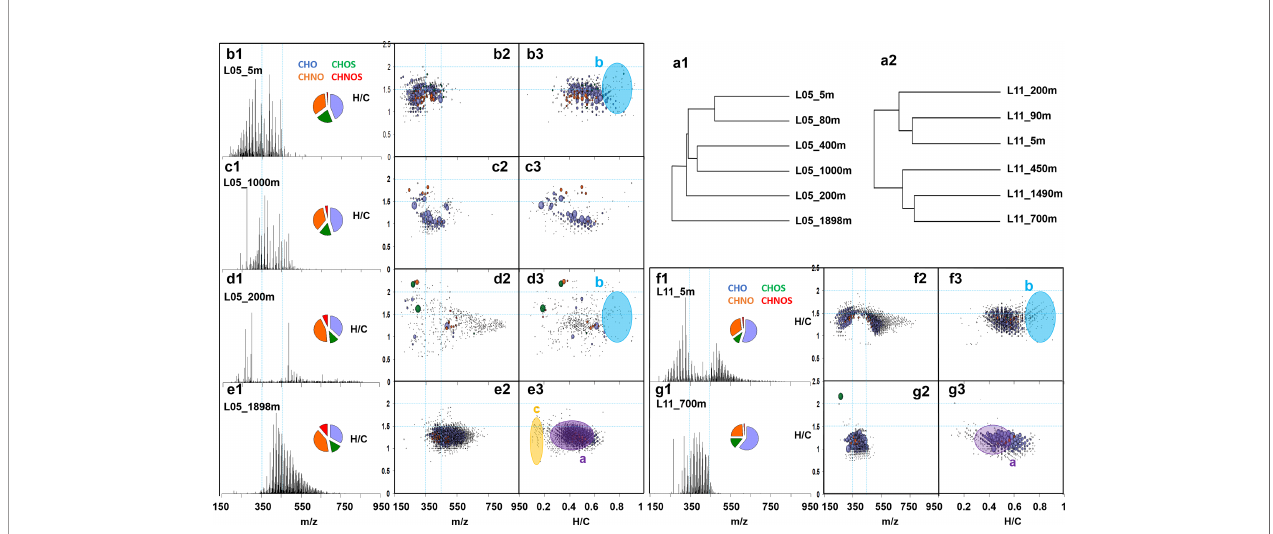
FIGURE 3 | Comparative analysis of intensity weighted negative ESI FTICR mass spectra of marine SPE-DOM in stations L05 and L11 produced hierarchical cluster analysis (HCA) diagrams (a1, a2). From top to bottom rows: FTICR mass spectra from m/z 150-950 with the assigned molecular compositions and relative proportions of color coded CHO (blue), CHOS (green), CHNO (orange) and CHNOS (red) molecular series, shown as van Krevelen diagrams and mass edited H/C ratios of the relatively more abundant compositions found in near surface layers (L5_5m and L5_80m) (b1-b3), mesopelagic layers (L5_400m and L5_1000m) (c1- c3), top mesopelagic layer (L5_200m) (d1-d3), L05 deep (e1-e3), upper layers (L11_5m, L11_90m and L11_200m) (f1-f3), and deep layers (L11_450m, L11_700m and L11_1490m) SPE-DOM. Section a : CRAM; section b : Carbohydrates and tannin-like compounds; section c : Less oxygenated CHOS molecular